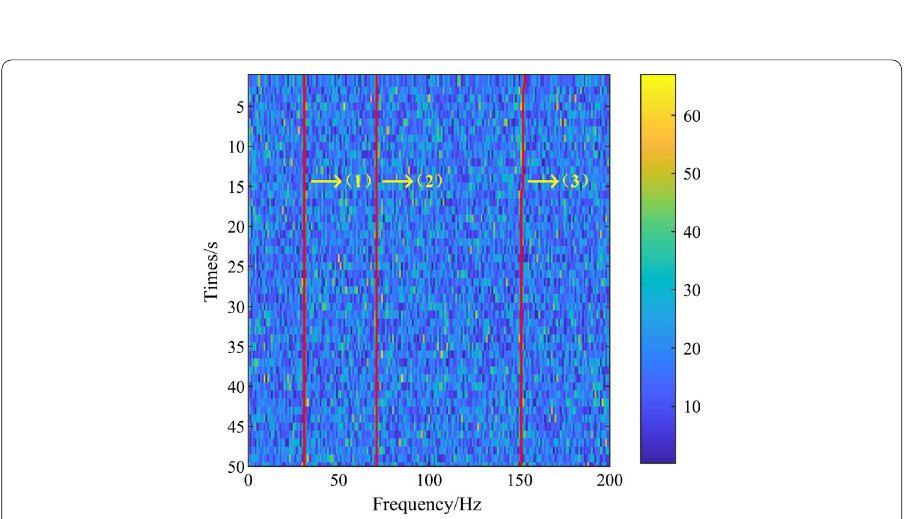
Fig. 12 Line-spectrum-extraction results of proposed algorithm at